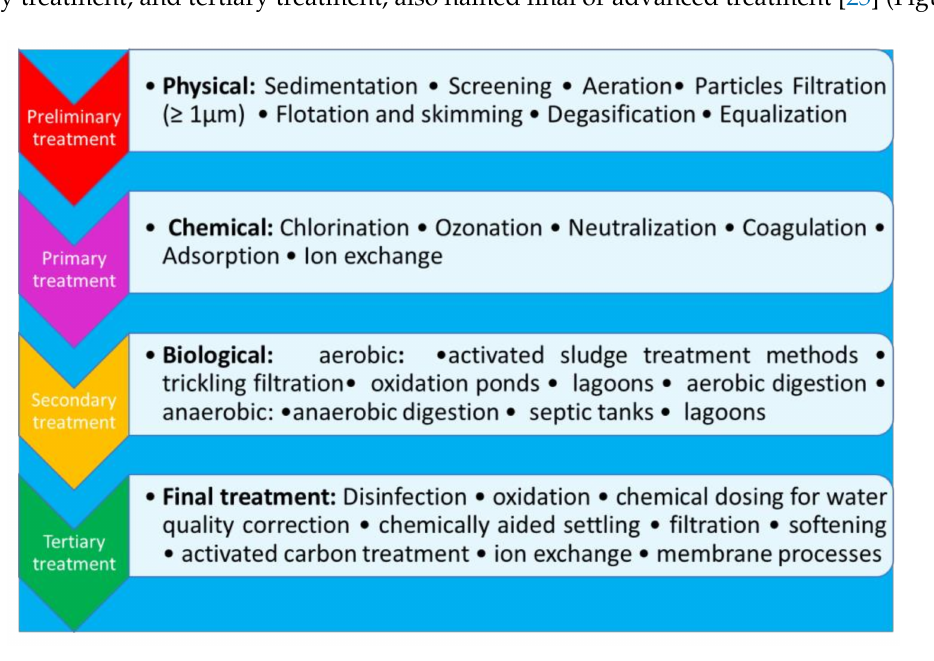
Figure 1. Classification of wastewater treatment